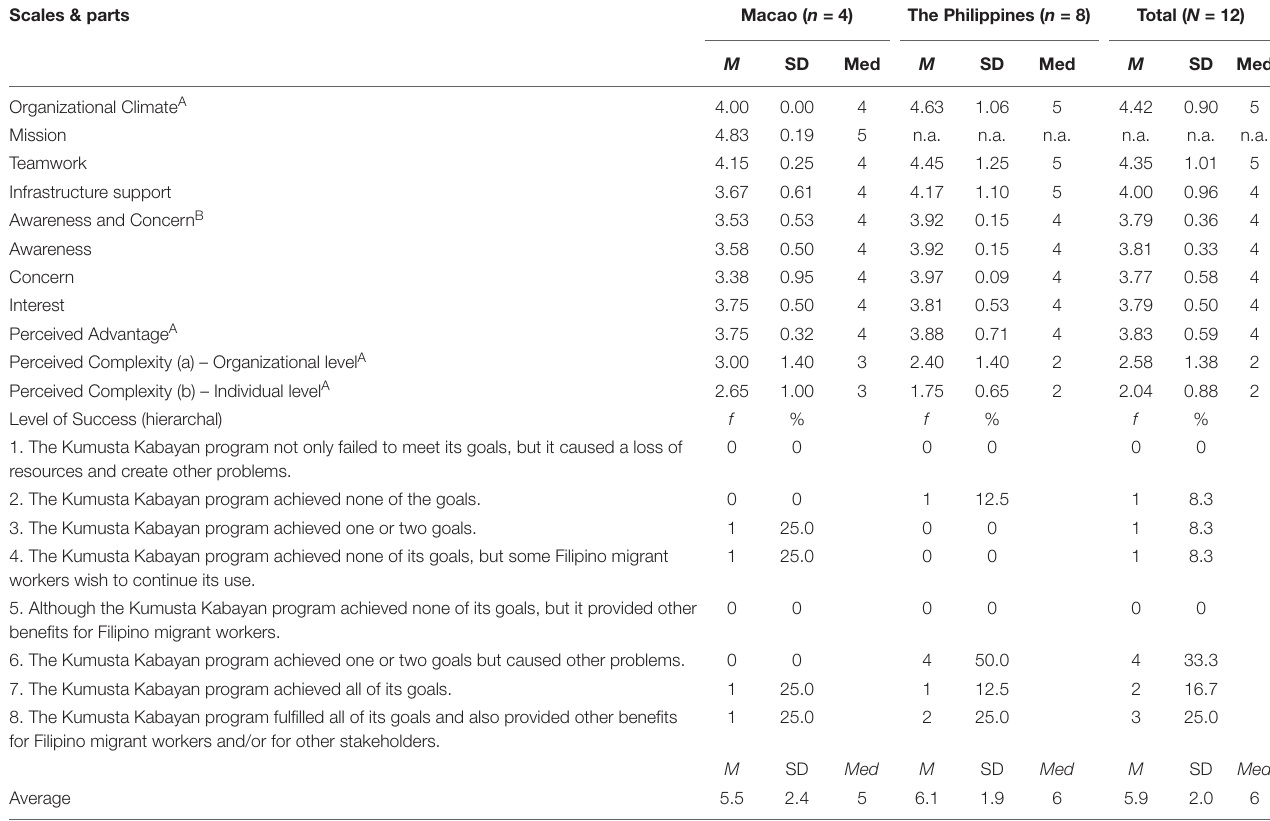
TABLE 1 | Characteristics of participants in online